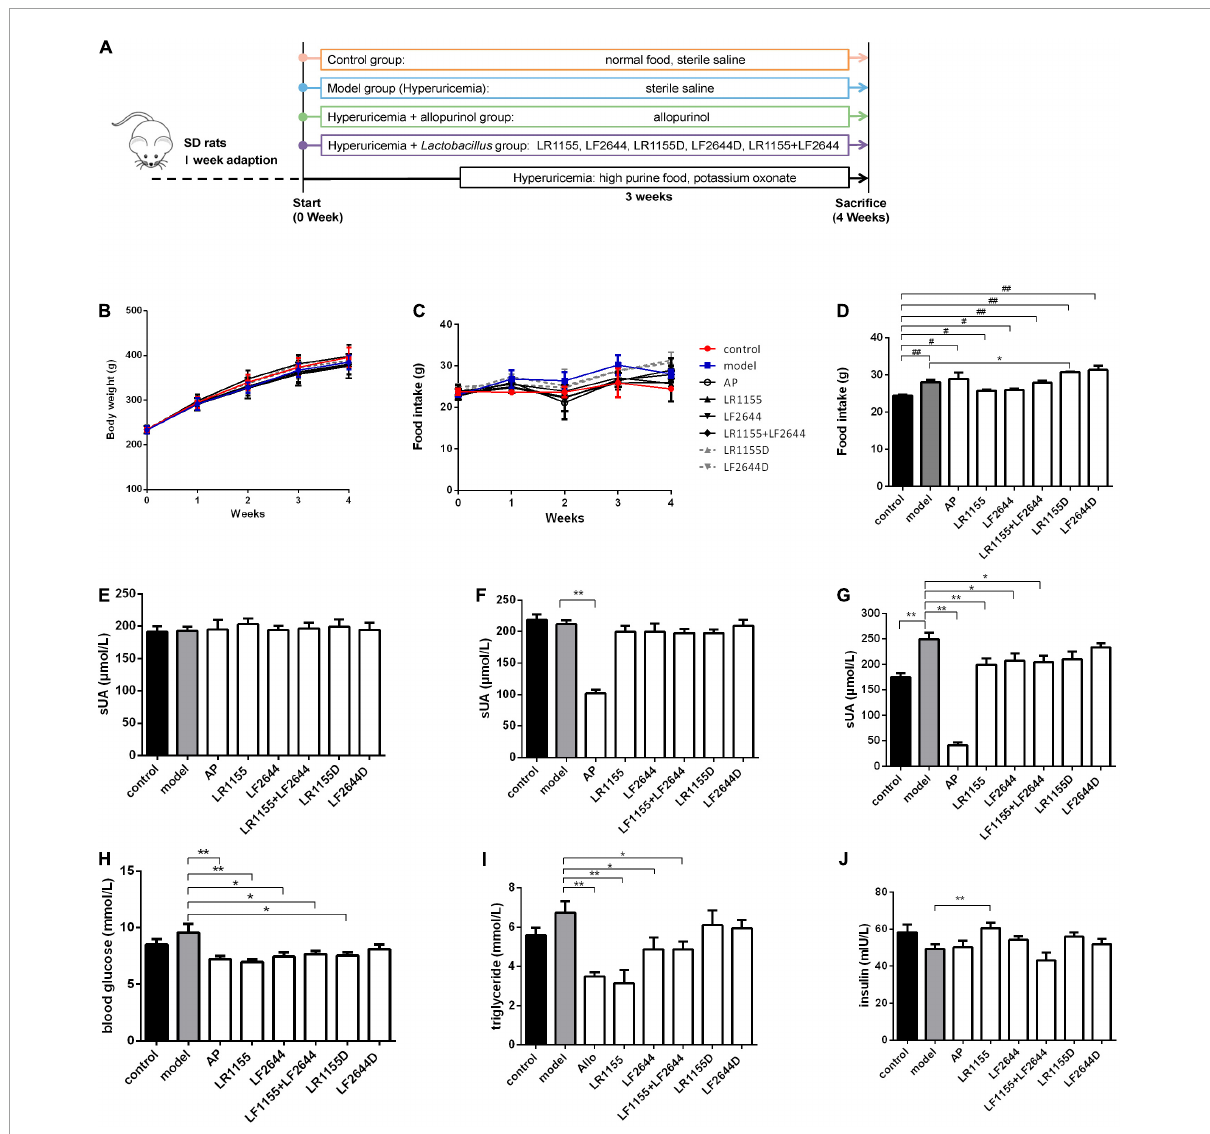
FIGURE1 Effects of LR1155 and LF2644 on body weight, food intake and metabolic parameters in hyperuricemia rats. (A) The timeline of the rat experiment. (B) Body weight and (C) food intake during the experiment. (D) Food intake on week 4. (E–G) Serum UA levels on weeks 0, 1, and 4. (H) Blood glucose, (I) triglyceride and (J) insulin levels at the end of the experiment. PO, potassium oxonate; AP, allopurinol; LR1155D and LF2644D, heat-killed LR1155 and LF2644. Data are expressed as mean ± SEM ( n = 10–12 per group). * P < 0.05, ** P < 0.01 vs. the model group, # P < 0.05, ## P < 0.01 vs. the control group.